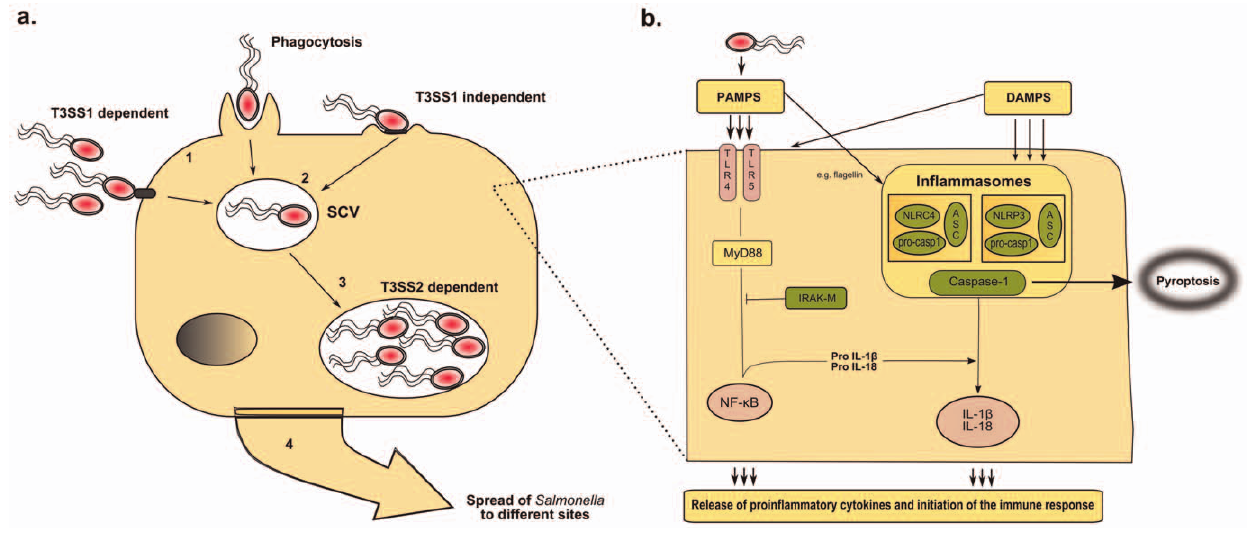
Figure 3. Salmonella and its first encounter with the host. (a) The intracellular life of Salmonella . Invasion of phagocytic and non-phagocytic cells. Salmonella is a facultative intracellular pathogen that can be found in a variety of phagocytic and non-phagocytic cells, in which it is able to survive and replicate. To establish this intracellular niche, the T3SS1 and -2 play a predominant role; key virulence factors are involved in accessing and utilizing these cells [36]. After ingestion, intestinal colonization follows and Salmonella enters enterocytes and dendritic cells in the intestinal epithelium [36]. Subsequently, Salmonella that reach the submucosa can be internalized by resident macrophages via different mechanisms: by phagocytosis, active invasion using the T3SS1 or T3SS1-independent invasion using fimbriae or other adhesins on the bacterial surface. (1) Salmonella -containing-vacuole. Following internalization Salmonella remains within a modified phagosome known as the Salmonella containing vacuole (SCV) and injects a limited number of effector proteins, such as SipA, SipC, SopB/SigD, SodC-1, SopE2, and SptP into the cytoplasm. These effectors cause rearrangements of the actin cytoskeleton and SCV morphology among other changes. (2) Replication within the SCV. Salmonella survives and replicates within the SCV, where it is able to avoid host antimicrobial effector mechanisms. The T3SS2 is required for systemic virulence in the mouse and survival within macrophages. (3) Transport of Salmonella to distant sites. After penetration of the M cells, the invading microorganisms translocate to the intestinal lymphoid follicles and the draining mesenteric lymph nodes, and some pass on to the reticuloendothelial cells of the liver and spleen. Salmonella organisms are able to survive and multiply within the mononuclear phagocytic cells of the lymphoid follicles, liver, and spleen [36]. (b) Host–pathogen interaction in typhoid and non-typhoid Salmonella . Simplified scheme of the first encounter between Salmonella spp. and the immune system. Specified cells such as neutrophils, macrophages, dendritic, phagocytic, and epithelial cells recognize specific pathogen associated molecular patterns (PAMPs) and danger-associated-molecular patterns (DAMPs), thereby eliciting an immune response. PAMPs such as LPS, Flagella, and bacterial DNA can trigger TRL4, TRL5, and TRL9, respectively. TLR-induced activation of NF- k B is essential for the production of pro-IL-1 b , pro-IL-18, which can be negatively regulated by IRAK-M [90]. The NLRs are situated in the cytosol and can also recognize PAMPs. However, NLRP3 is triggered by a different, yet unknown, mechanism, although DAMPs are thought to play a crucial role. TLR, toll-like receptors; LPS, lipopolysaccharide; NF- k B, regulated nuclear factor kappa-light-chain-enhancer of activated B cells; IRAK-M, IL-1R-assiociated kinase-M; IL, Interleukin; ASC, apoptotic speck protein containing a caspase recruitment domain; NLR, NOD-like receptors (including NLRP3 and NLRC4); MyD88, myeloid differentiation primary response gene